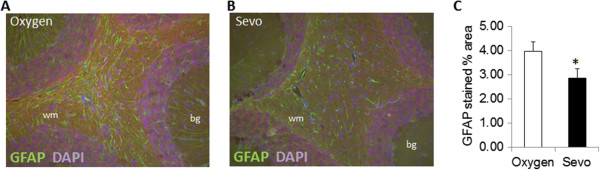
Sevoflurane reduces glial activation in cerebellum of experimental autoimmune encephalomyelitis (EAE) mice. Representative sagittal sections from (A) oxygen-treated and (B) sevoflurane-treated mice were stained with antibody to glial fibrillary acidic protein (GFAP) to detect activated astrocytes. (C) The total GFAP+ staining per field of view was quantified. Data are mean ± SEM of n = 6 sections per animal, three mice per group; *P <0.05 versus oxygen. WM, white matter; BG, Bergmann glia.